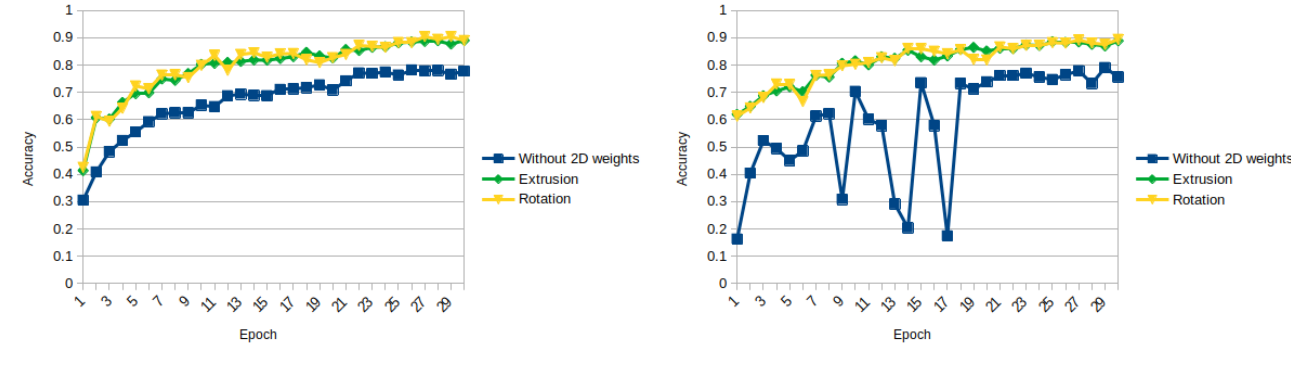
Figure 14. Inception ResNet 3D